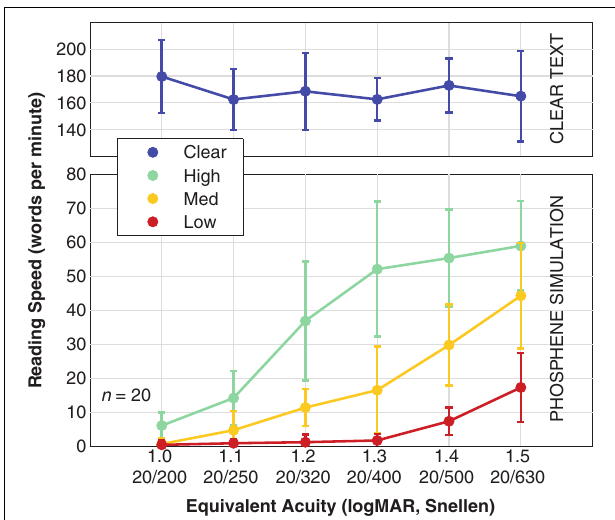
FIGURE 7 | Reading speed. Population data are shown for reading speed vs. font size (expressed as equivalent acuity), broken down by viewing condition. The upper panel shows the Clear condition where text is shown in the clear as a control (blue). The lower panel shows the results for simulated artificial vision with the three phosphene patterns, High density (green), Medium density (yellow), and Low density (red). Points are the mean, error bars are the standard deviation of population values. The two panels have different vertical scales; the control viewing condition has been separated out to display more detail in the simulation viewing conditions. Logistic fits were not performed with these data as only one condition spanned lower to upper performance plateaus as necessary for a valid fit, and we do not have direct evidence that the asymptotes are identical for all three conditions. As at least two curves would be necessary for meaningful comparisons, a fit for the High data is not